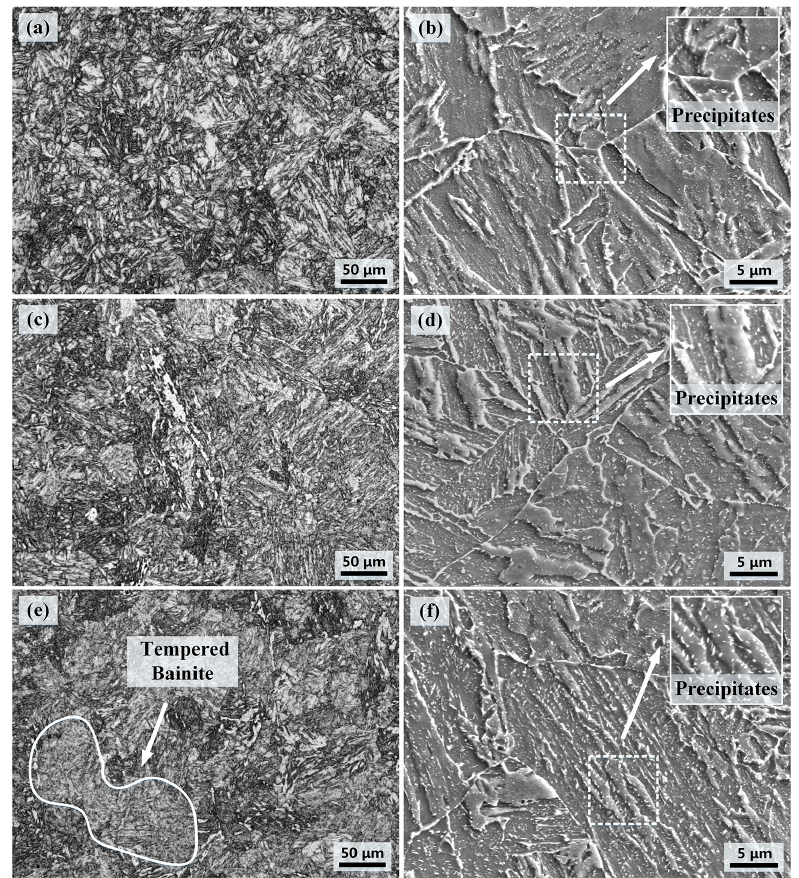
Figure 1. Optical microscopy (OM) ( a , c , e ) and SEM ( b , d , f ) micrographs of the experimental steels. ( a , b ) sub-surface, ( c , d ) 1/4 thickness ( t /4), ( e , f ) 1/2 thickness ( t /2).